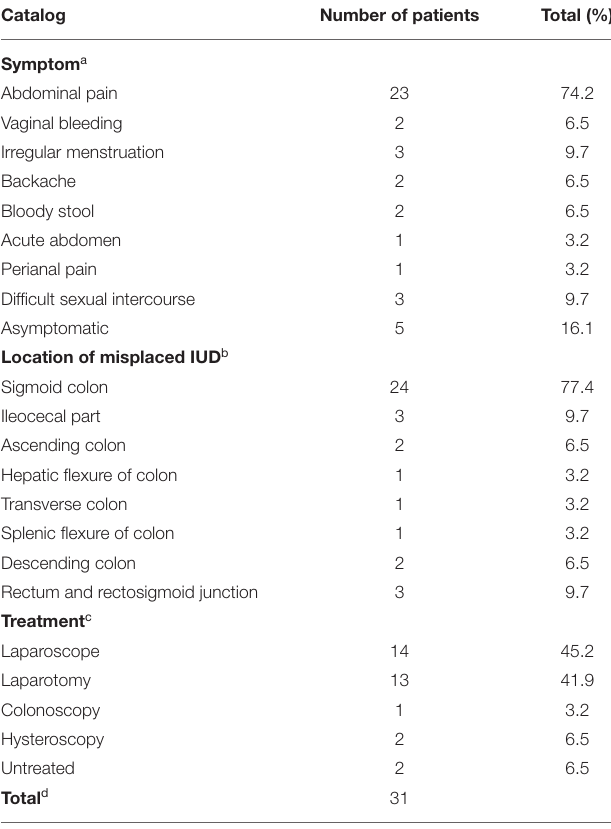
TABLE 2 | Clinical presentation and intraoperative findings of intracolon